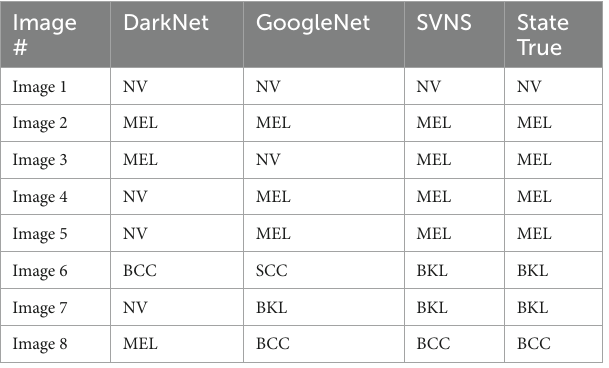
Figure 3. There are three processes involved in achieving transfer learning: altering the last learnable layer, freezing the initial layers, and accelerating the learning process for the deeper layers. The accuracy for the Xception, AlexNet, and DenseNet models stays the same and does not increase with the number of epochs approximately 0.74, 0.71, and 0.73 correspondingly as stated in Table 3. TABLE 5 SVNSS classification of eight